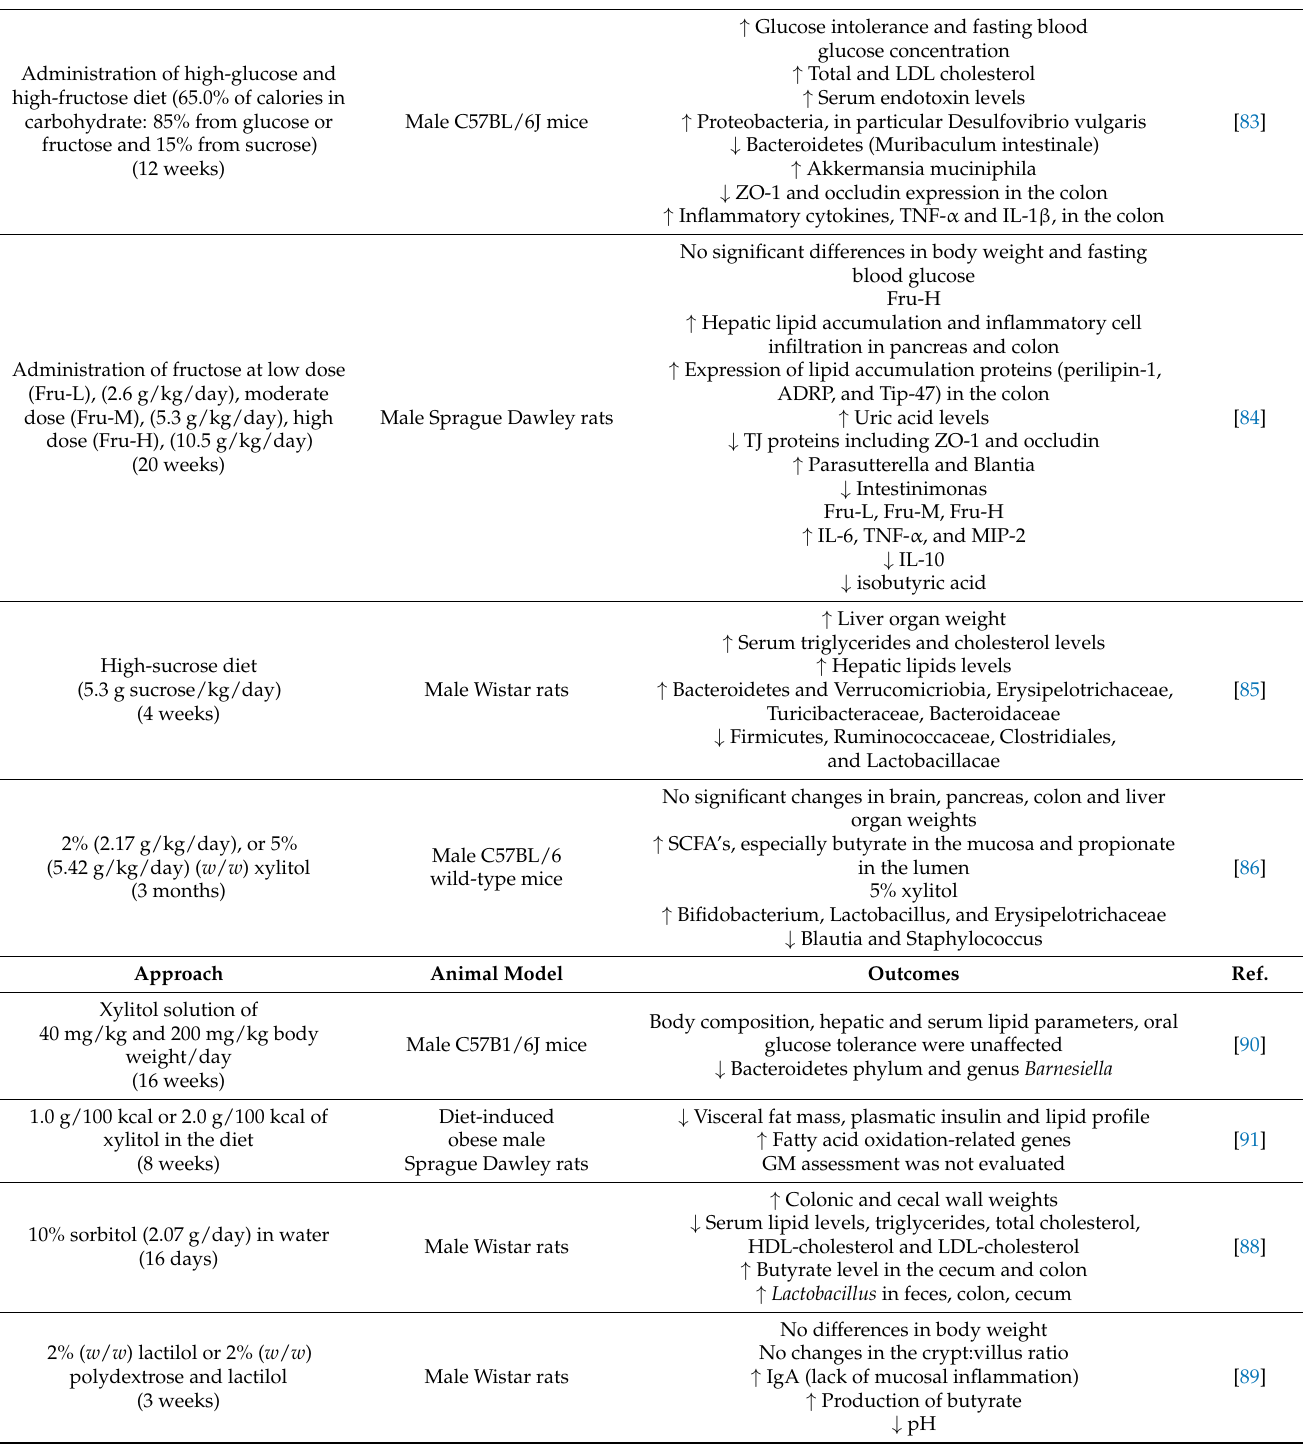
Table 1. Effects of nutritive sweeteners on gut microbiota and metabolic health.